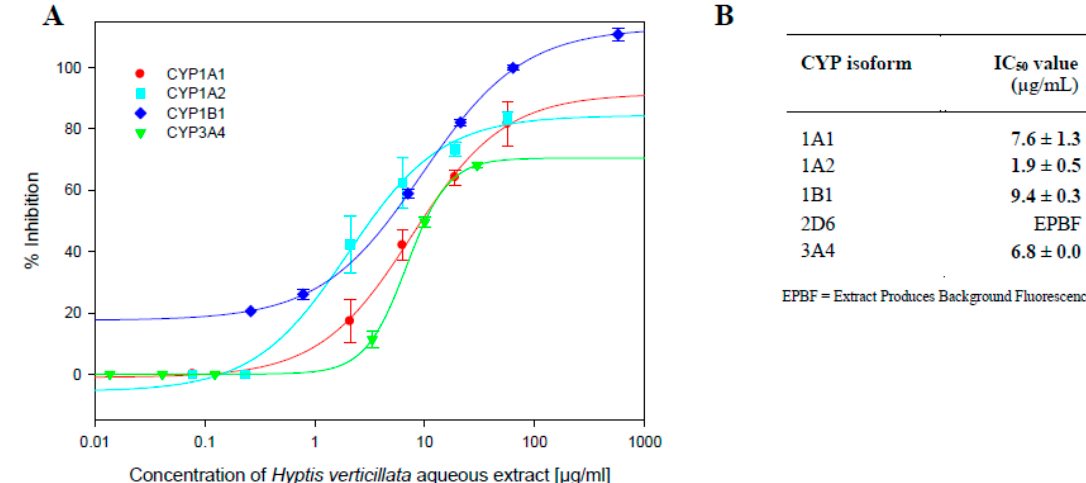
Figure 1. ( A ) Impact of H. verticillata aqueous extract on CYP activities. Human CYPs 1A1, 1A2 catalyzed 7-ethoxy-3-cyanocoumarin (CEC) (0.5, 5.0 µM respectively) metabolism, CYP1B1 catalyzed 7-ethoxyresorufin (ERes) (0.37 µM) metabolism and CYP3A4 catalyzed 7-benzyloxy-4-trifluoromethylcoumarin (BFC) (50 µM) metabolism were determined in the presence of varying concentrations of reconstituted freeze-dried aqueous extract of H. verticillata ranging from 0.02 to 575 µg/mL, as described in the Materials and Methods section. Control enzyme activity (mean ± SEM) for CYPs 1A1, 1A2, 1B1 and 3A4 was 1.43 ± 0.2, 1.49 ± 0.001, 0.95 ± 0.001 and 0.86 ± 0.000 (µM/min/pmol) of CYP, respectively. Data are expressed as mean percentage of enzyme activity for experiments carried out in triplicate; ( B ) Summary of results.